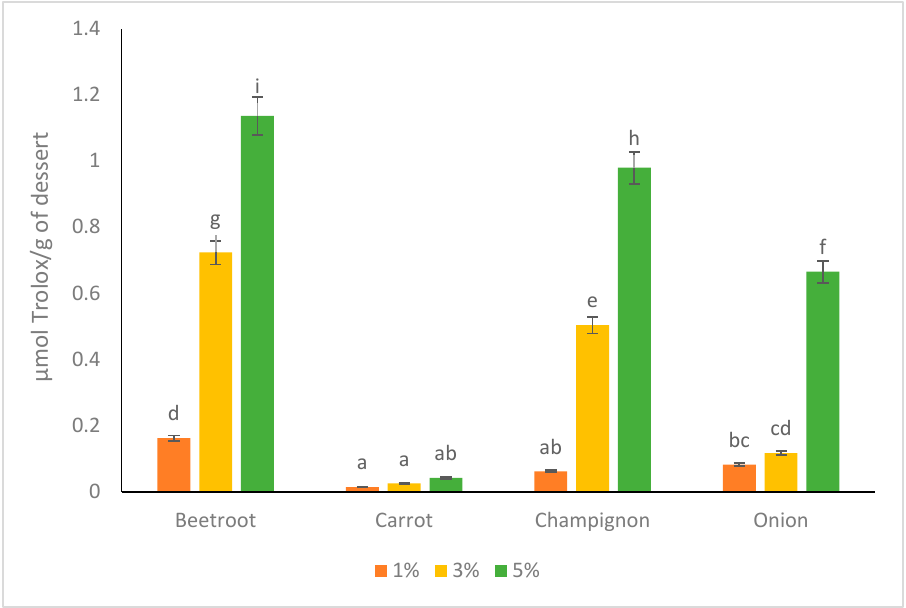
Figure 4. Effect of different amounts of dried vegetable powders on fat-free dairy desserts’ antioxidative properties (DPPH). Letters (a–i) indicate significant differences at p < 0.05 (Tukey’s HSD test).